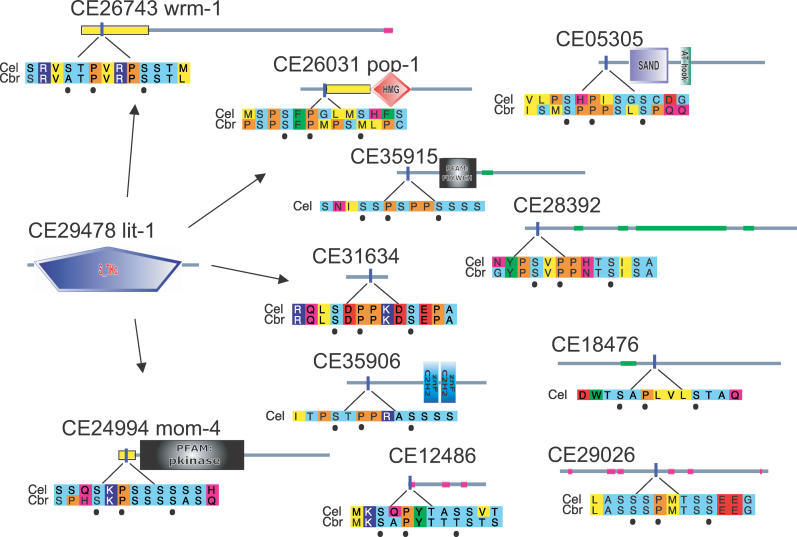
A Lit-1 MAP Kinase SxPxxxS MotifThe MAP kinase lit-1 surrounded by its interaction partners containing the SxPxxxS motif. Details are as for Figure 3. Yellow boxes show the location of deletion mutants known to affect the interaction. Cbr, C. briggsae; Cel, C. elegans.